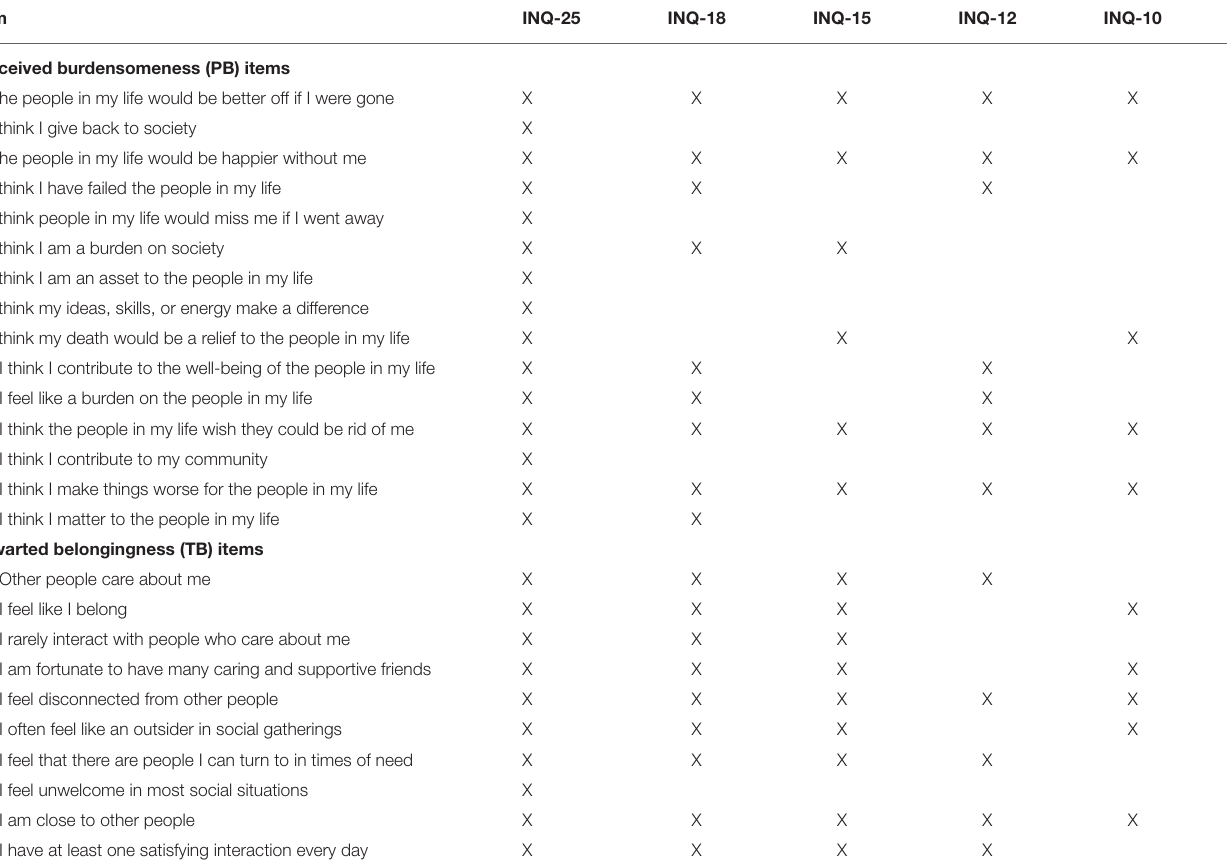
TABLE 1 | Items included in each version of the INQ. Item INQ-25 INQ-18 INQ-15 INQ-12